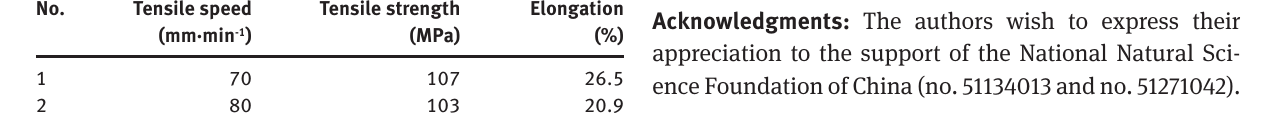
Table 3: The tensile test data of clad slab under different casting speed. No. Tensile speed Tensile strength (mm·min -1 ) (MPa)